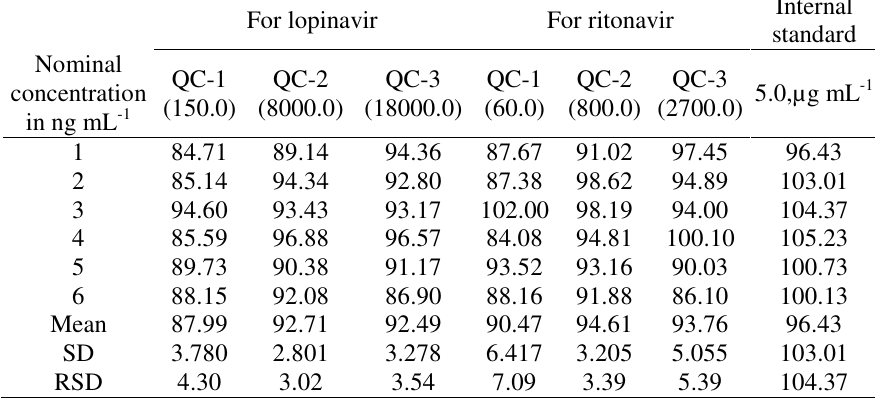
Table 2. Extraction recovery of drug and internal standard. For lopinavir For ritonavir